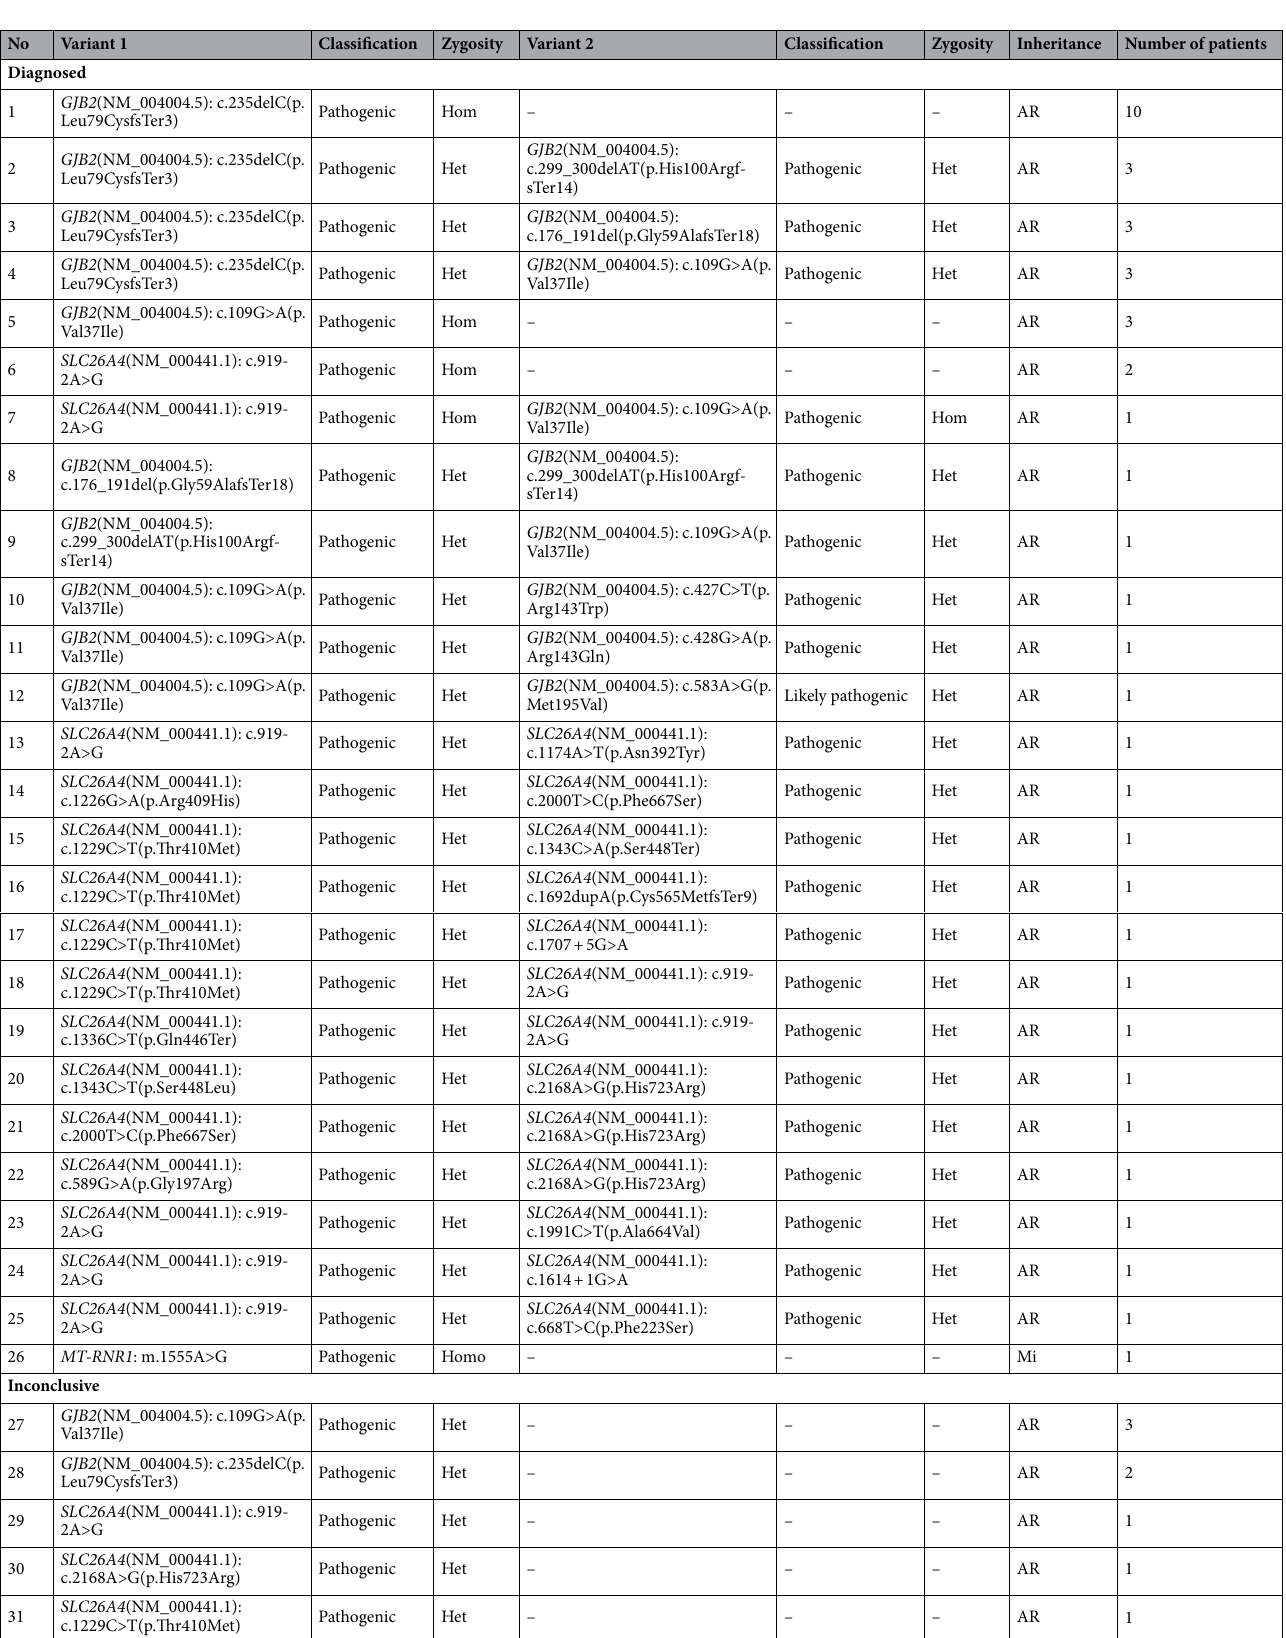
Table 2. Genotype of NSHL patients detected by Multiplex PCR sequencing. Hom homozygous, Het heterozygous, Homo homoplasmy, AR autosomal recessive, AD autosomal dominant, Mi